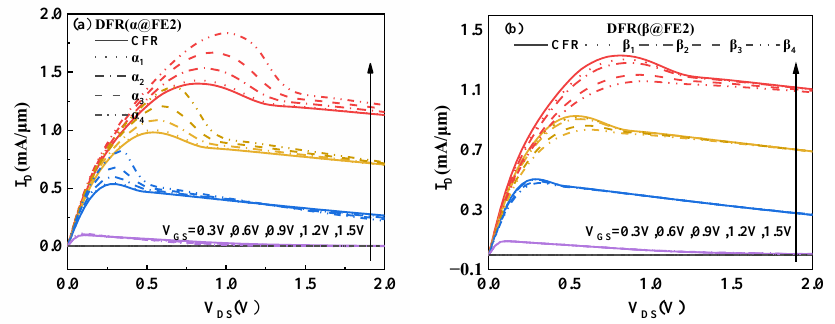
Figure 8. Comparison of output characteristic curves of the CFR-NCFET and DFR-NCFET with ( a ) variable α in FE2 region, ( b ) variable β in FE2 region.